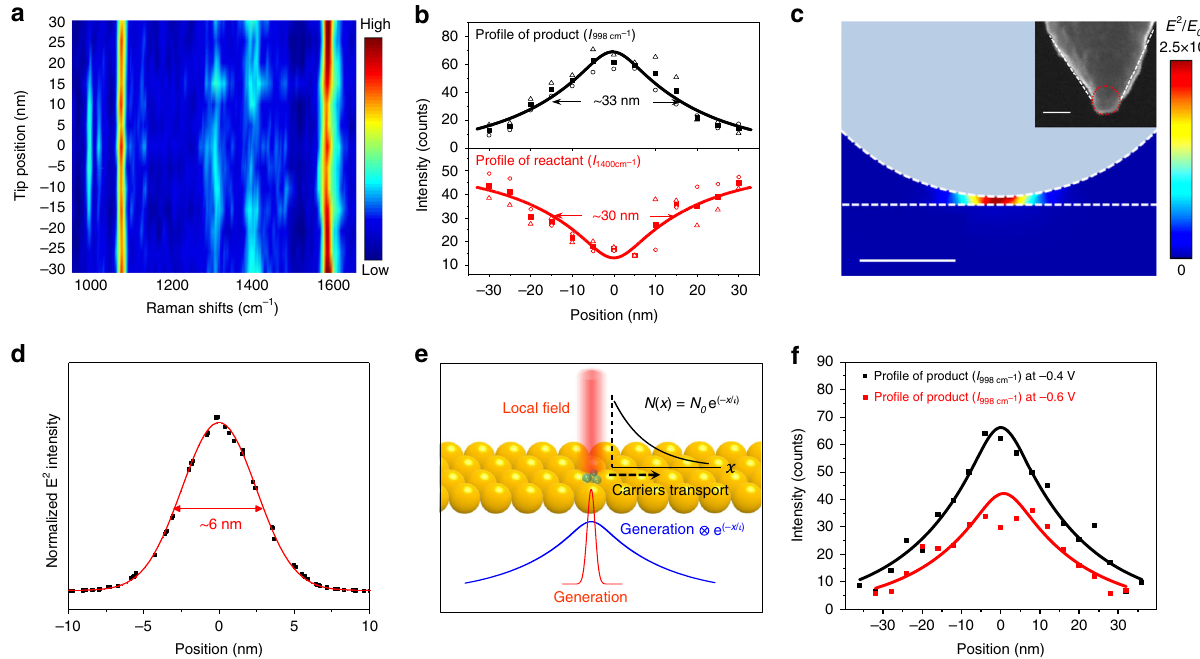
Fig. 4 Pro fi le of the reaction region on the substrate under Ag tip. a Color-coded intensity map of the line-trace TERS spectra across a reaction region. The reaction was induced at the sample potential of − 0.4 V under a laser power of 0.7 mW. The line-trace TERS spectra were acquired with the sample potential at − 0.7 V. Bias: 100 mV, I tunneling : 800 pA. b Plots of intensities of the 998 cm − 1 peak (top) and 1400 cm − 1 peak (bottom) with the tip position. The open triangle, circle symbols represent the intensities in the trace and retrace spectra. The solid square symbols represent the average intensities of the trace and retrace spectra. The color-coded intensity map and the Raman spectra of the trace and retrace are shown in Supplementary Fig. 16. The fi tted lines were obtained by using the function AE ð x Þ 2 (cid:2) e ð(cid:3)j x j = ι Þ (cid:2) R ð x Þ , where A is a constant, E ð x Þ 2 is the pro fi le of plasmonic electric fi eld intensity in d , R ( x ) is the TERS spatial resolution pro fi le obtained from Supplementary Fig. 15. c Calculated plasmonic electric fi eld ( E 2 ) distribution when the Ag tip is positioned on the Au surface, the scale bar is 10 nm. Inset: scanning electron microscope image of the Ag tip, the scale bar is 50 nm. d Calculated E 2 pro fi le on the substrate surface in the plasmonic gap. Red line is fi tted using a Gaussian function. e Schematic illustration of hot carrier generation and transport on surface. f Pro fi le of the reaction induced at − 0.6 and − 0.4 V for comparison. The color-coded intensity maps of the line-trace TERS spectra are shown in Supplementary Fig. 19. Bias: 100 mV, I tunneling : 800